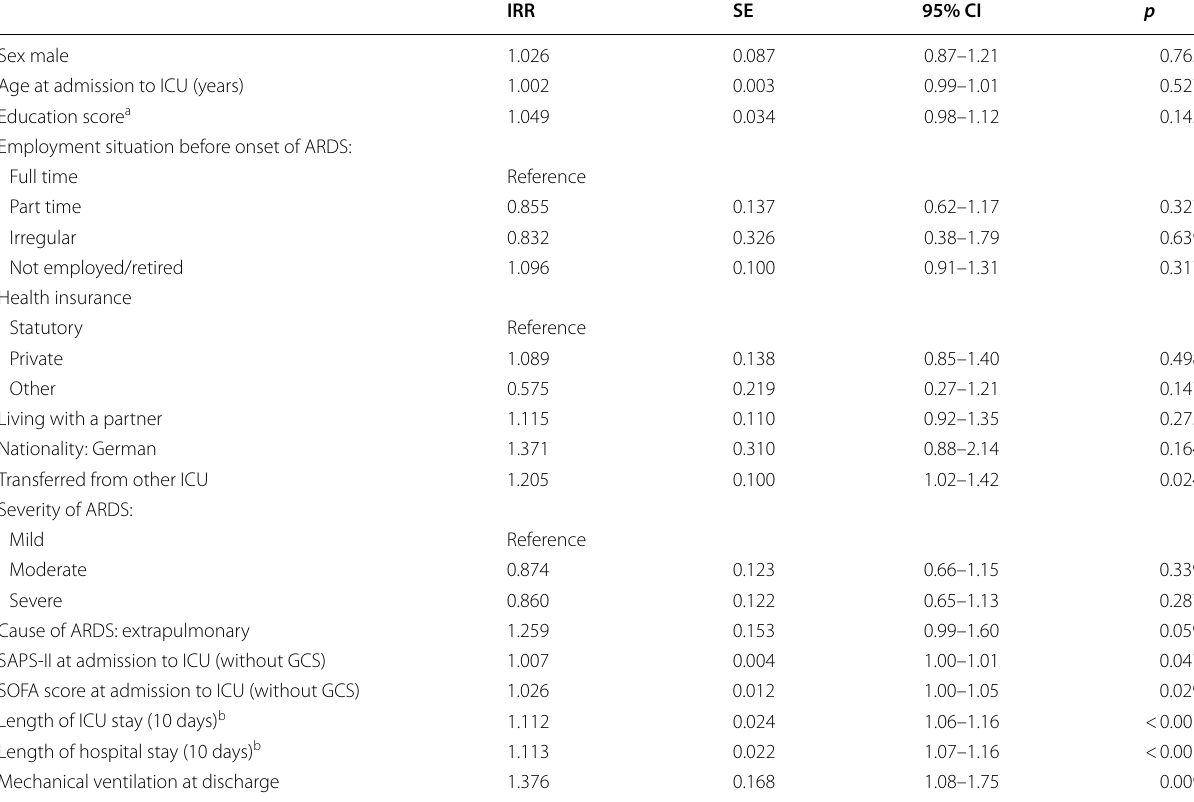
Table 3 Univariable negative binomial regression analyses of days of hospitalization after discharge from ICU